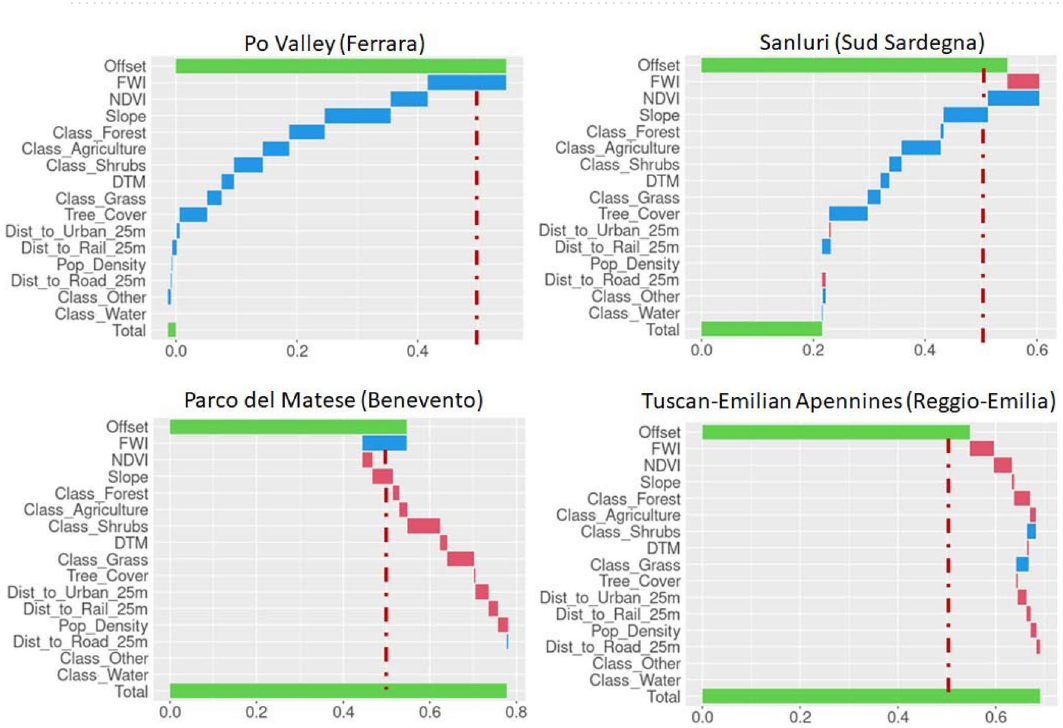
Figure 6. Explainability and classification results of 4 notable cases: Po Valley—True Negative (top left panel); Campidano Plain near Sanluri, South Sardinia—False Negative (top right panel); Parco del Matese, province of Benevento—True Positive (bottom left panel); Tuscan-Emilian Apennines—False Positive (bottom right panel). Fire Weather Index (FWI), Normalized Difference Vegetation Index (NDVI), Digital Terrain Model